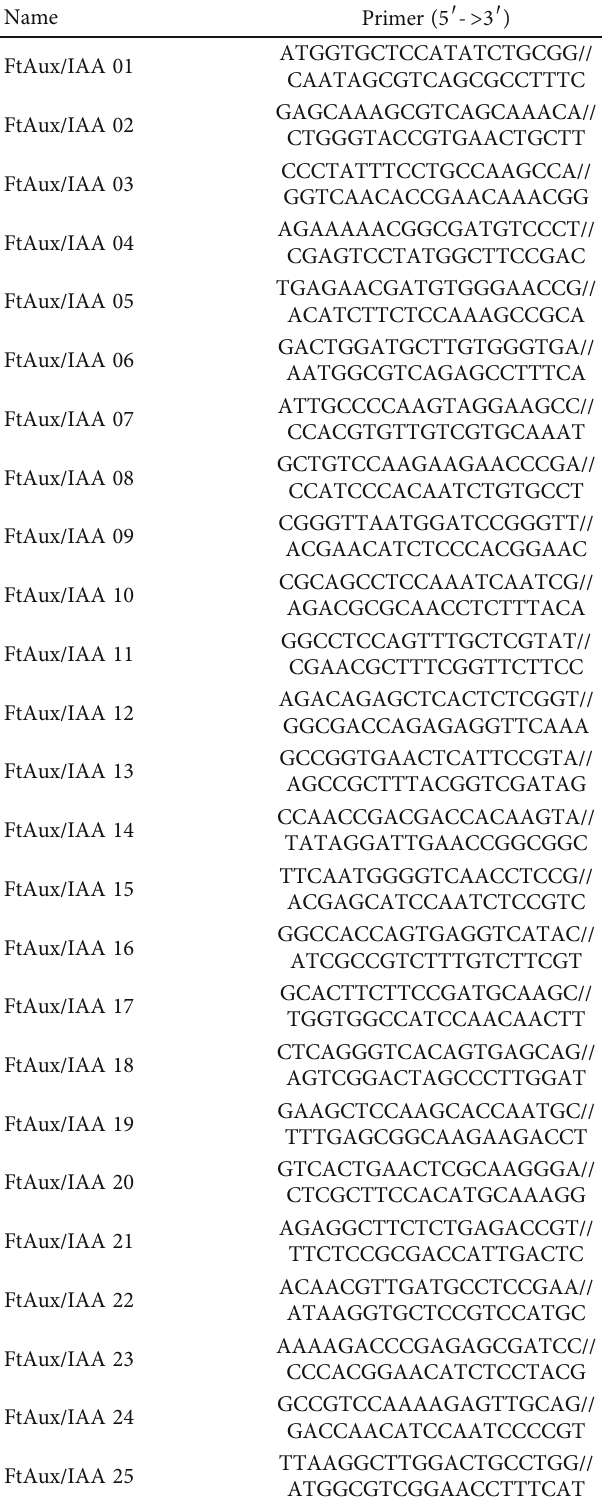
Table 2: Primer sequences of FtAux/IAA genes for